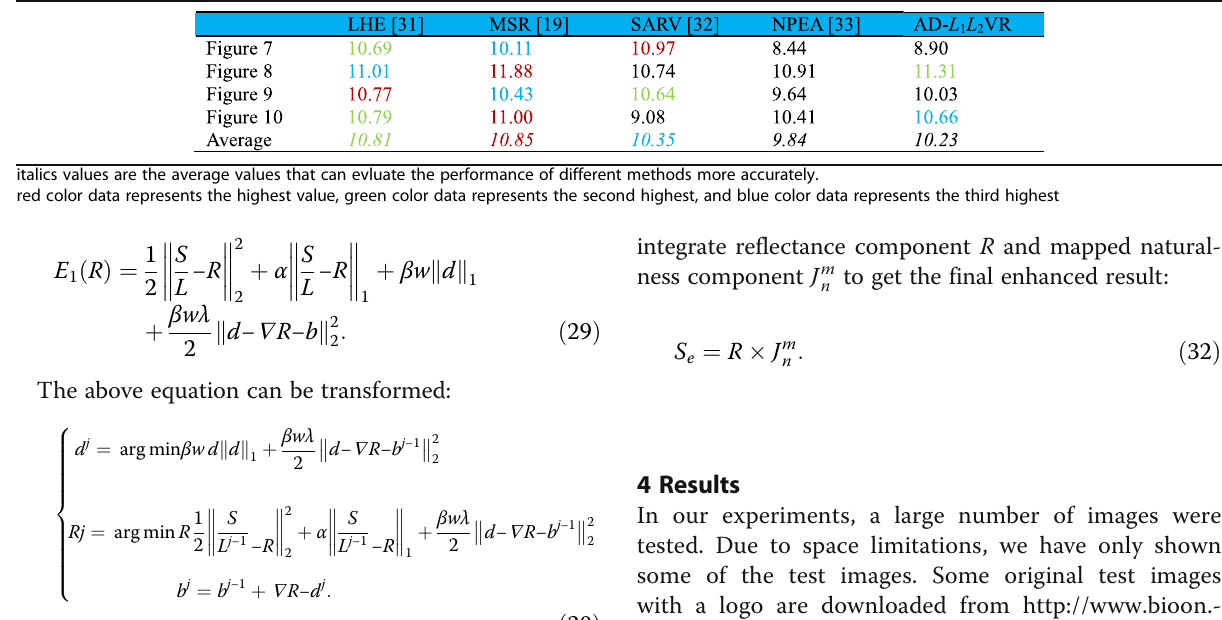
Table 1 Contrast of compared methods